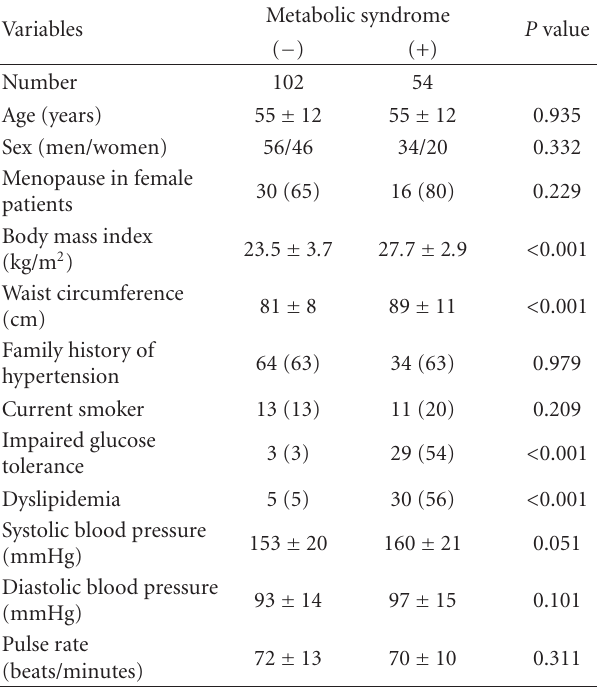
Table 1: Comparison of clinical characteristics between essential hypertensives with and without metabolic syndrome.